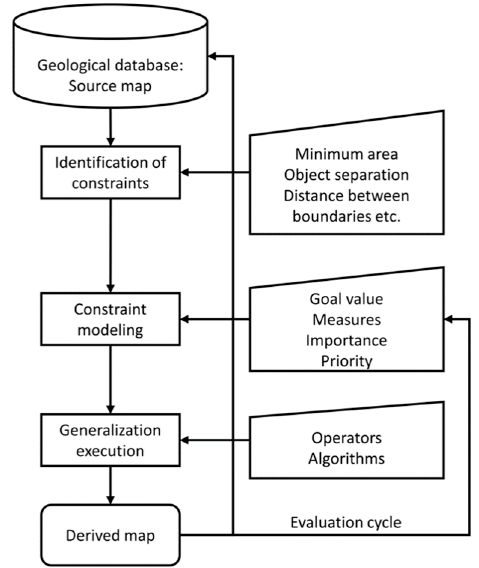
Figure 2. The overall workflow of the proposed methodology.